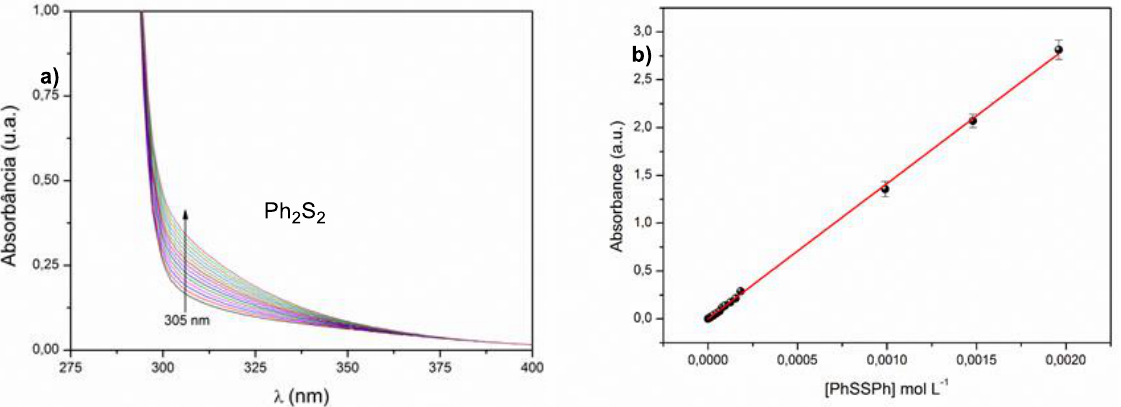
Figure 2. ( a ) UV-Vis spectrum of PhSH oxidation in the presence of H 2 O 2 and diselenide 3b as catalyst. [PhSH] = 10 mmol L −1 , [ 3b ] = 0.01 mmol L −1 and [H 2 O 2 ] = 15 mmol L −1 , in methanol at 25 °C; ( b ) Absorbance plotted against diphenyl disulfide concentration. The red line represents the linear fit. The coefficient of molar absorptivity in 305 nm was 1415 L mol −1 cm −1 (R 2 = 0.9996).